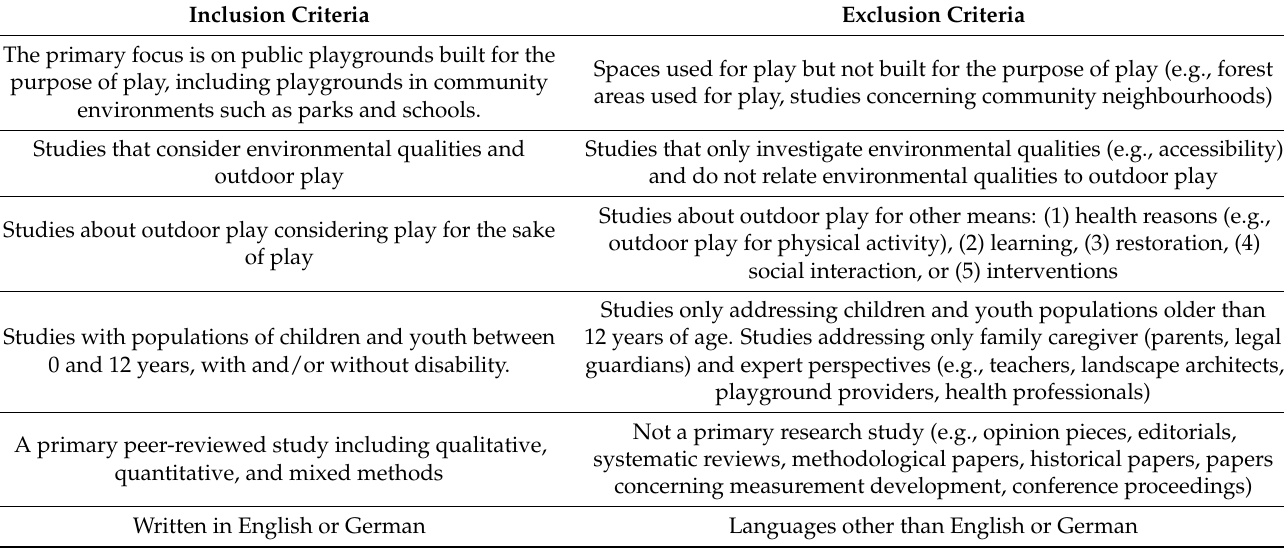
Table 2. Inclusion and exclusion